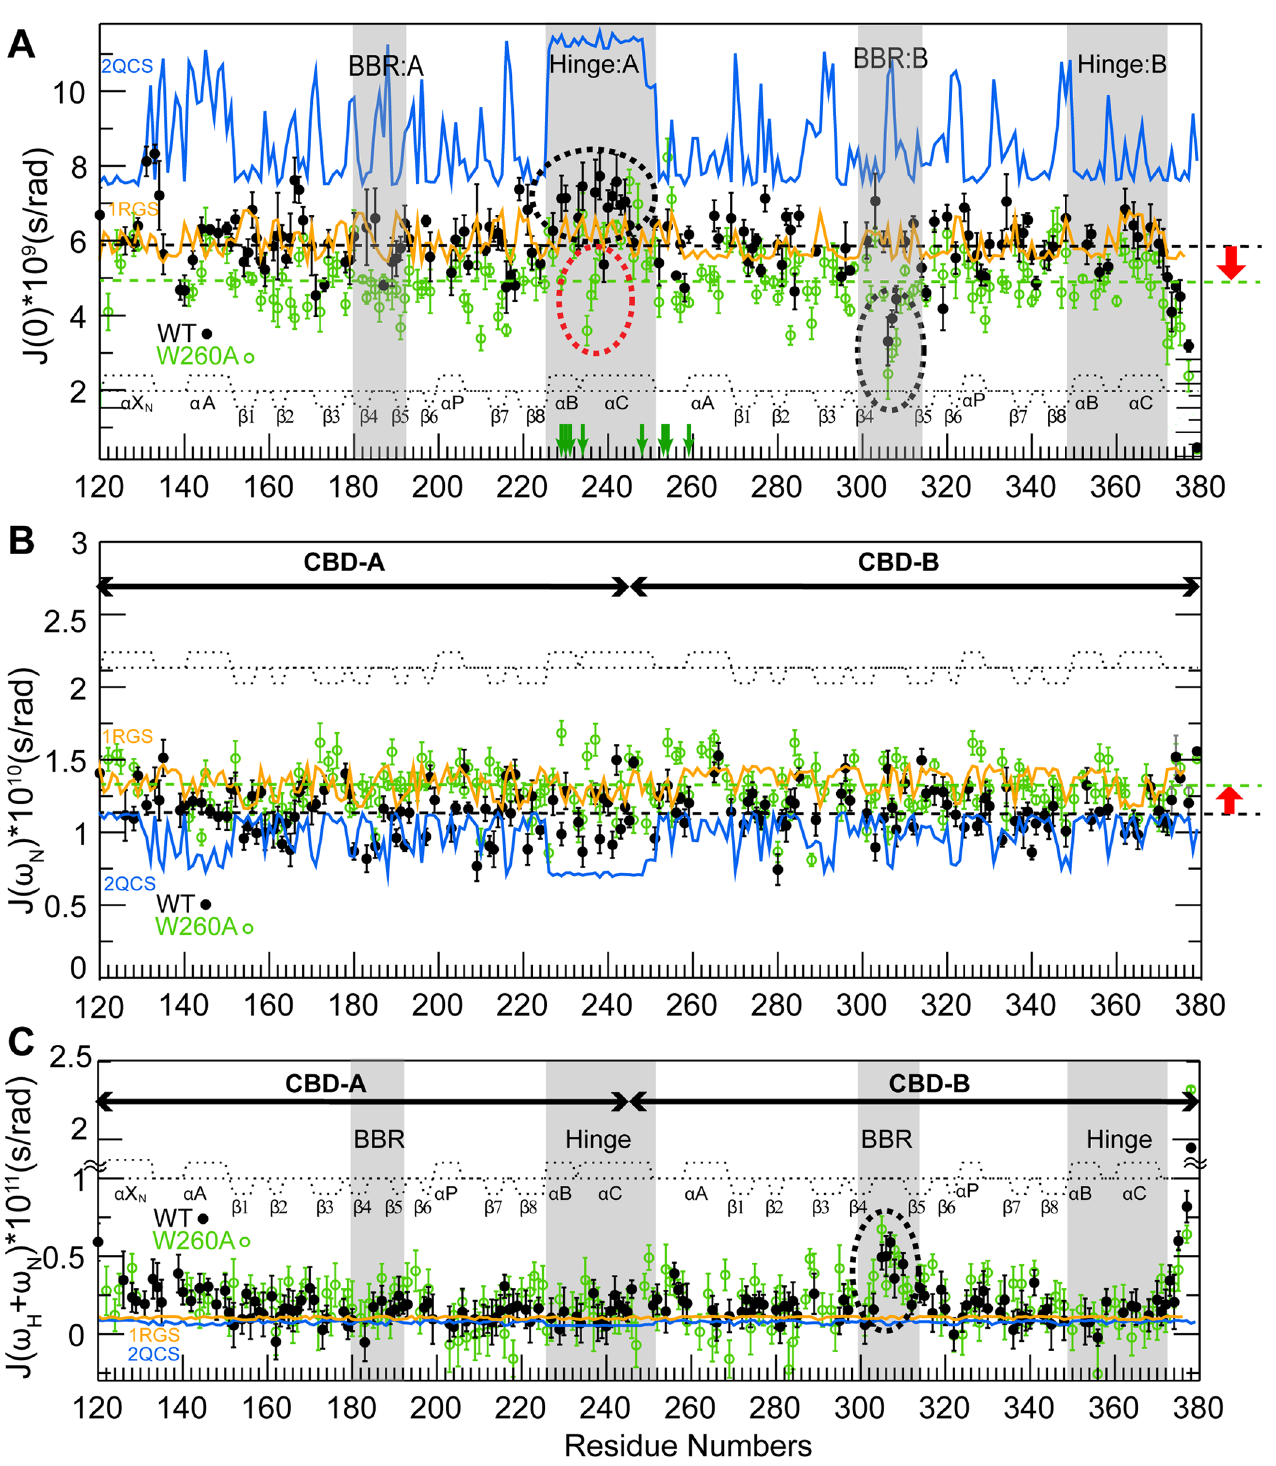
Fig 5. Intra- and inter-domain RI α dynamics. Dynamics of WT (black closed circles) and W260A (green open circles) RI α (119 – 379):cAMP 2 mapped through residue-specific reduced spectral densities at 0 Hz, ω N , and ω N + ω H frequencies in panels (A – C) , respectively. Green vertical arrows in panel (A) mark residues of the helical region between the two β -barrels that are subject to fast H/D exchange (within the dead time) in W260A but not in the WT sample. The reduced spectral densities predicted based on the cAMP 2 - and C-bound RI α structures in the absence of internal motions are shown in orange and blue, respectively. The PDB codes of the structures used for the reduced spectral densities prediction are reported in the figure. Key regions subject to